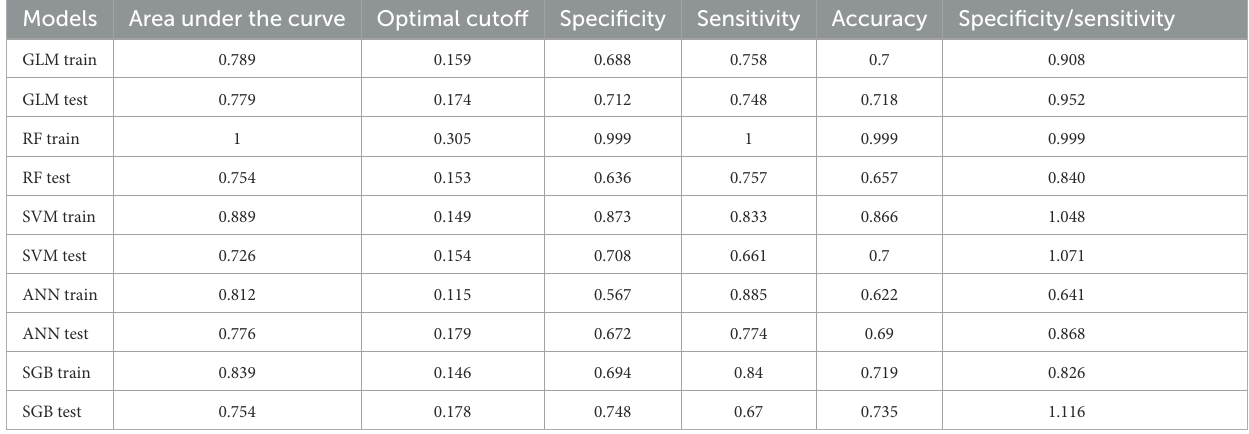
TABLE 2 Model performance